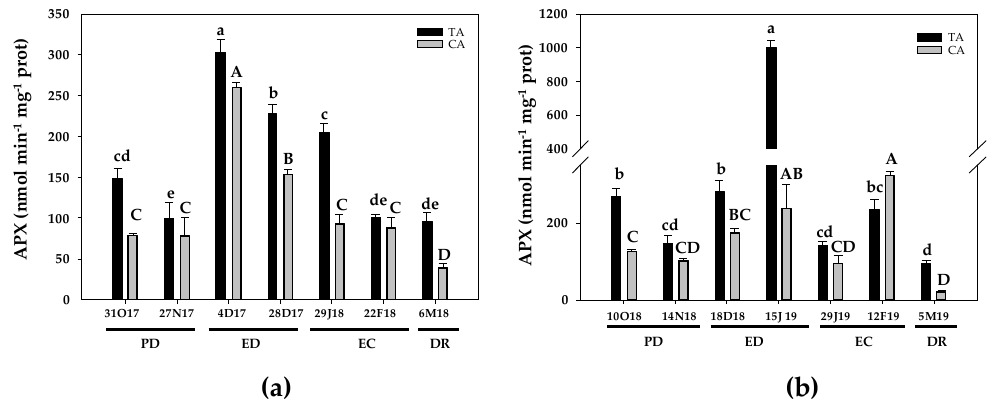
Figure 7. Evolution of ascorbate peroxidase (APX) activity in flower buds of peach ‘GEM020’ cultivated in two different geographical areas during the dormancy cycle on two seasons. ( a ): season 1 (2017–2018); ( b ): season 2 (2018–2019). Data represent the mean ± SE, n = 5. Different letters (lowercase and uppercase for the samples of the temperate (TA) and the cold area (CA), respectively) indicate significant differences according to Tukey’s multiple test ( p ≤ 0.05). PD: paradormancy; ED: endodormancy; EC: ecodormancy; DR: dormancy release. FW: fresh weight. The chill units accumulated at the different times and locations are shown in Supplemental file 1.